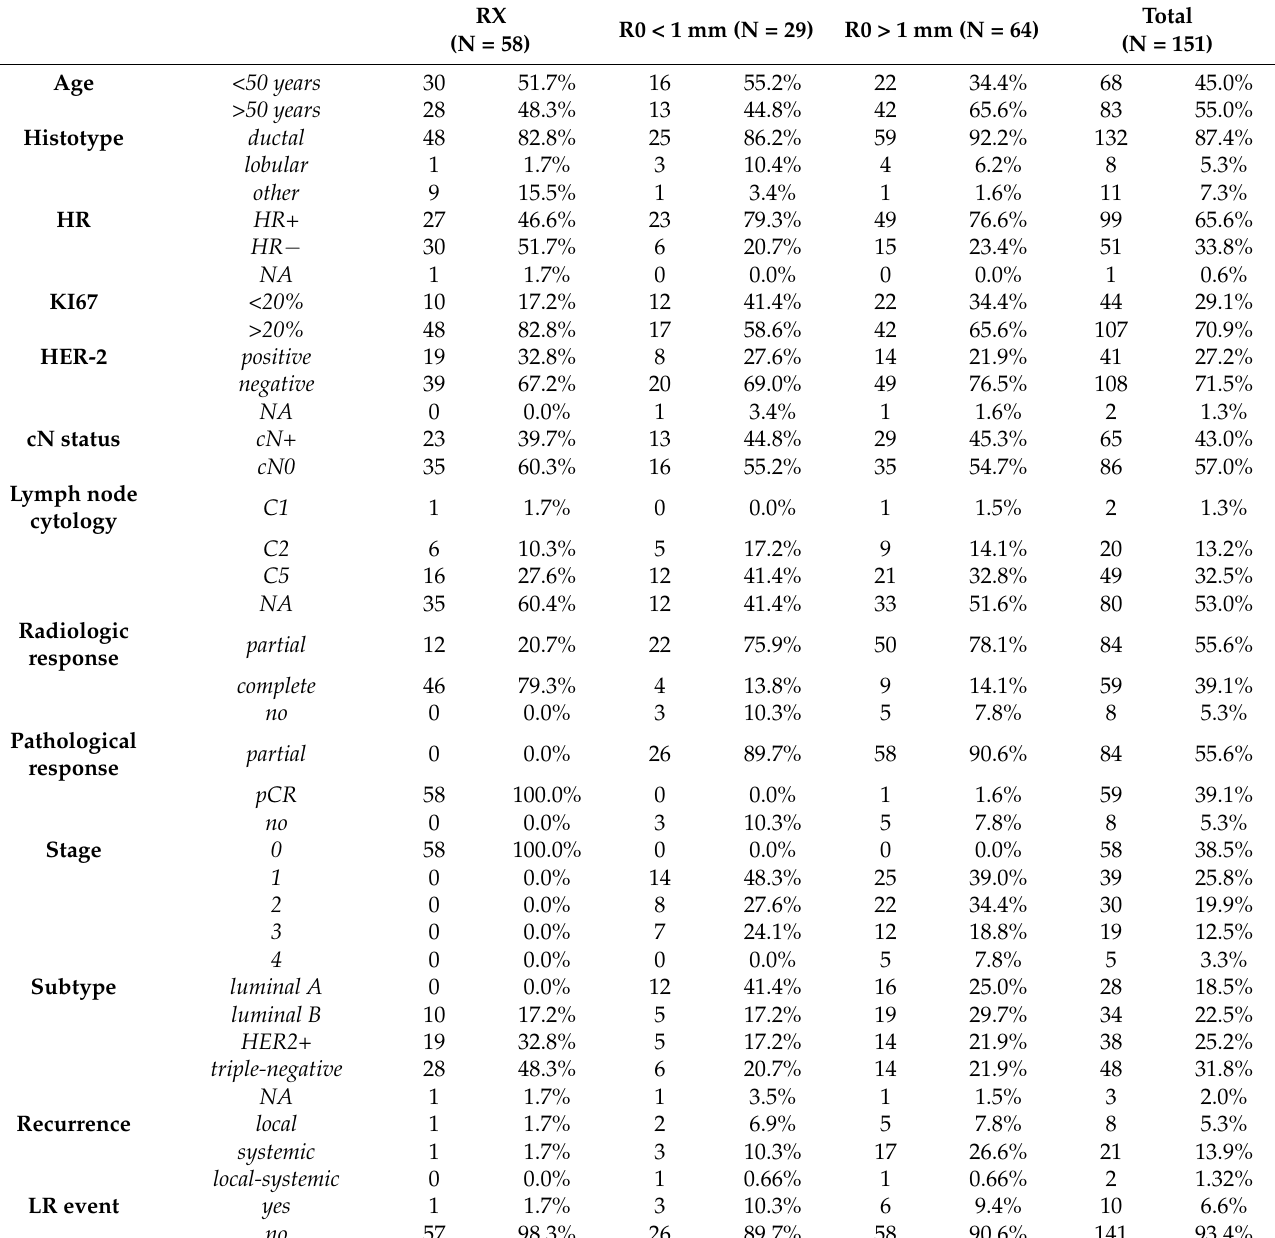
Table 1. Clinicopathological features and pattern of